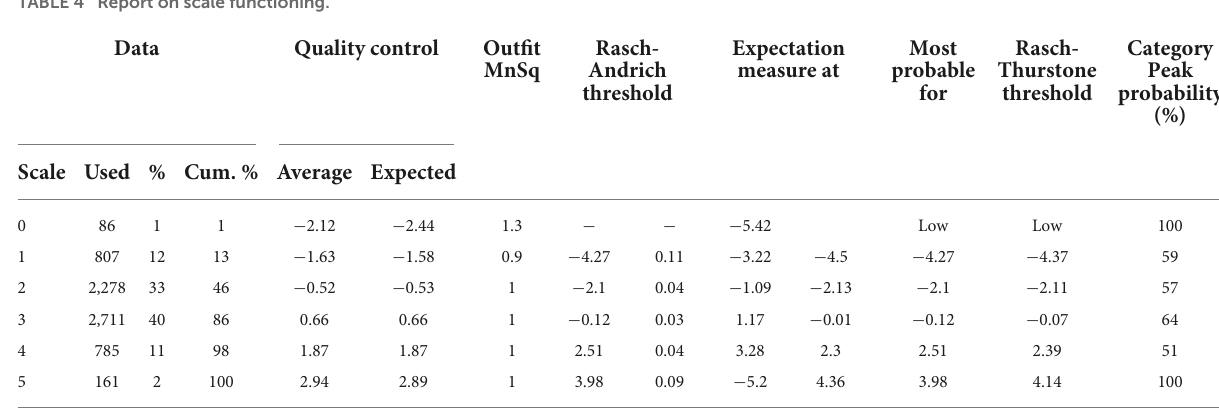
Expectation measure at